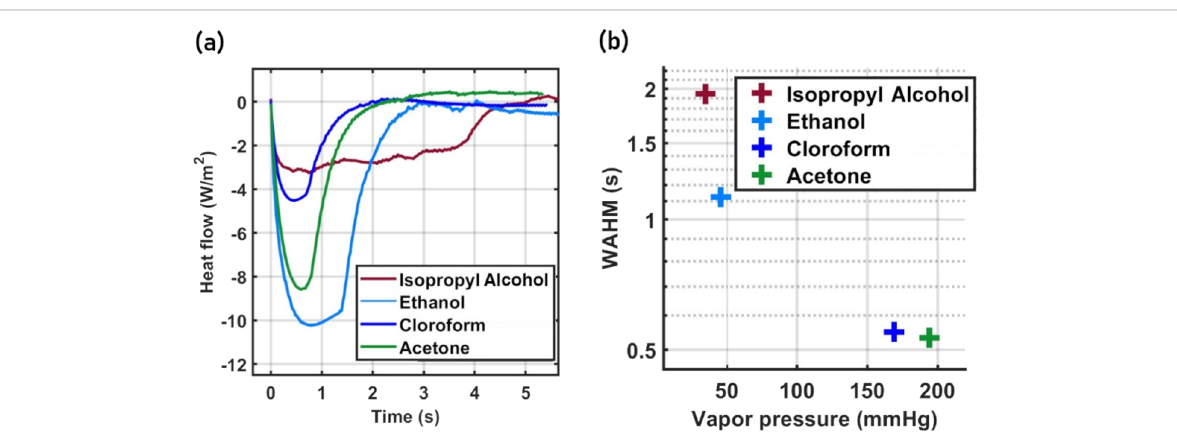
Figure 5: (a) Heat flow behavior of different solvents. (b) Correlation between the width at half maximum (FWHM) and the vapor pressure of the tested solvents.